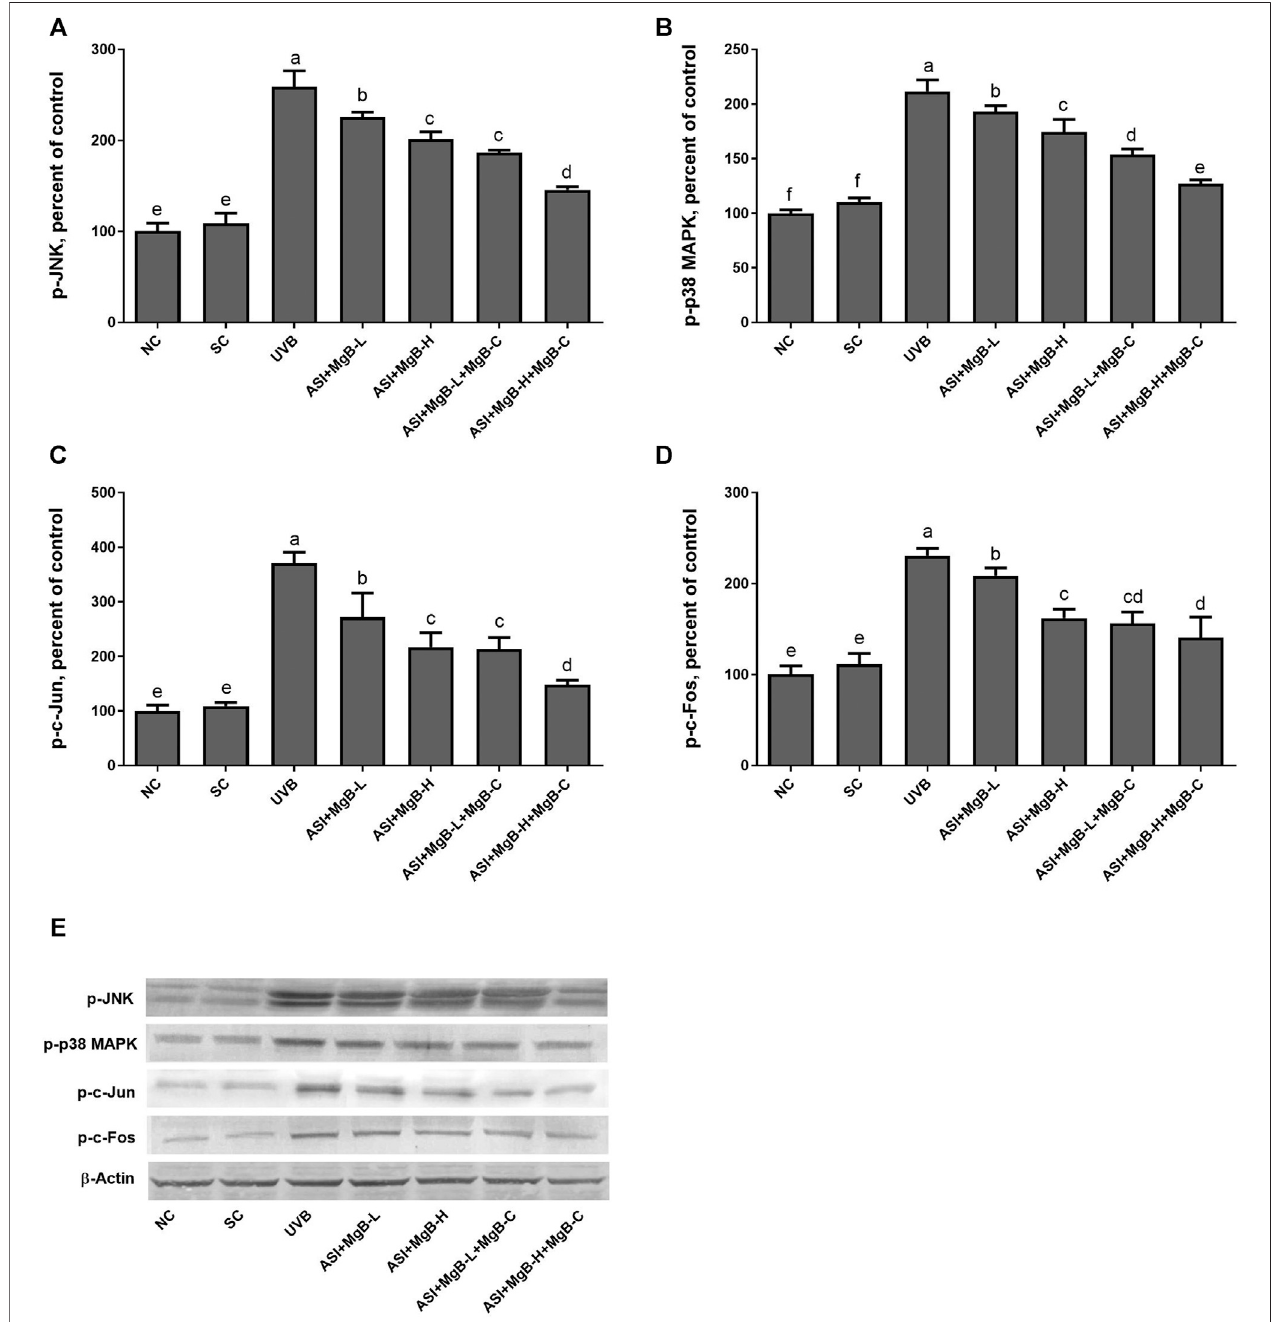
FIGURE 6 | Effect ofinositol-stabilized arginine silicate complex (ASI) and magnesium biotinate (MgB) on c-Jun N-terminal kinase (JNK; A ), p38 mitogen-activated protein kinase (MAPK); B ), AP1, activator protein 1 (c-jun; C and c-fos; D ) protein levels in rats with UVB-induced photoaging. Data are expressed as a percent of the control value. Each bar represents the mean and standard error of the mean. Blots were repeated at least 3 times. Western blot analysis was performed with actin includedensuringequalproteinloading (E) .Thedataarepercentagesofthecontrol. a – e :Valueswithinthebarswithdifferentsuperscriptsaresigni fi cantlydifferent (One-way ANOVA and Tukey ’ s post-hoc test, p <